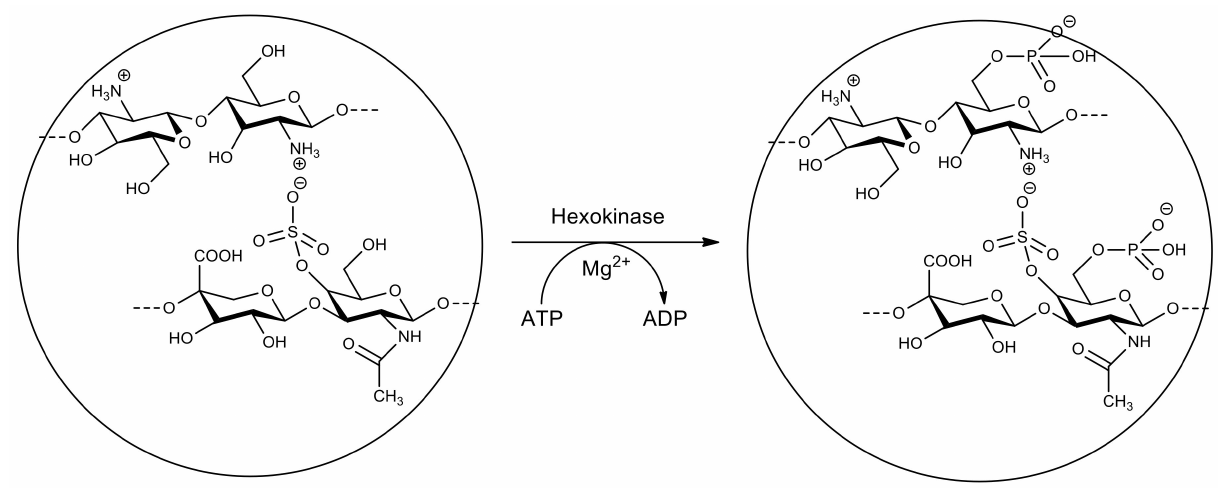
Figure 13. Phosphorylation of nanoparticles consisting of a chitosan–chondroitin sulfate complex using